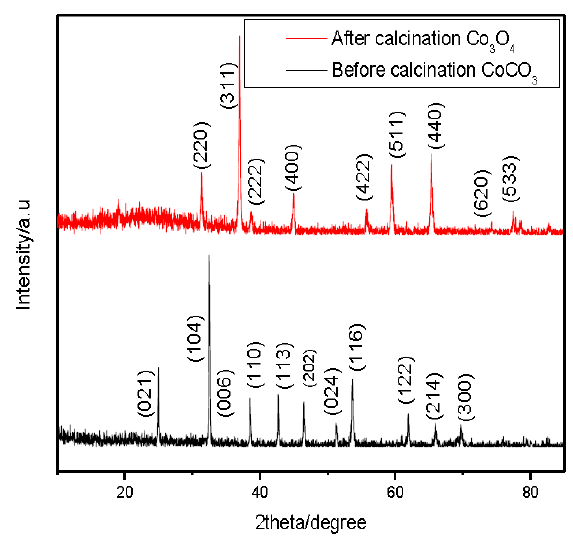
Figure 1: XRD patterns for product prepared by coprecipitation method before calcination (in black ) 1a and after calcination (in Red)